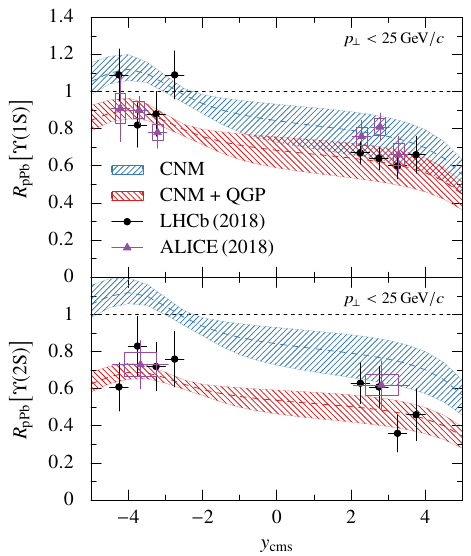
Figure 19. Calculated rapidity-dependent nuclear modification factors R p-Pb for the Υ ( 1 S ) (top) and √ Υ ( 2 S ) state (bottom) in p-Pb collisions at s NN = 8.16 TeV with preliminary ALICE data [93] (triangles) and LHCb data [90] (circles). Results for CNM effects that include shadowing, energy loss, and reduced feed-down (dashed curves, blue) are shown together with calculations that incorporate also QGP effects (solid curves, red). The error bands result from the uncertainties of the parton distribution functions that enter the calculations. From Dinh, Hoelck, Wolschin